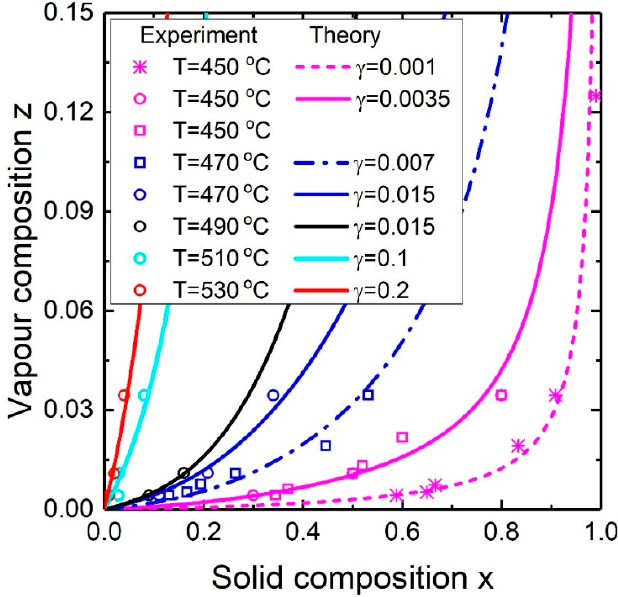
Figure 8. Theoretical (steady-state) and experimental vapor-solid composition dependences for In x Ga 1- x Sb NWs for different temperatures. The stars represent experimental data from [36]; the rest of the experimental data (squares and circles) are obtained from [35].